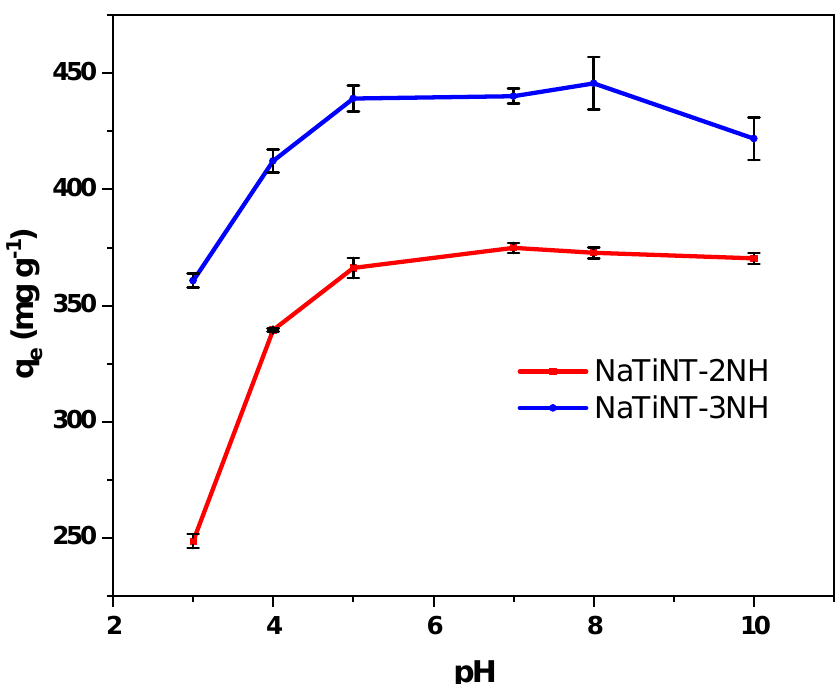
Figure 7. The effect of pH on RB adsorption using the adsorbent NaTiNT − 2NH and NaTiNT − 3NH.